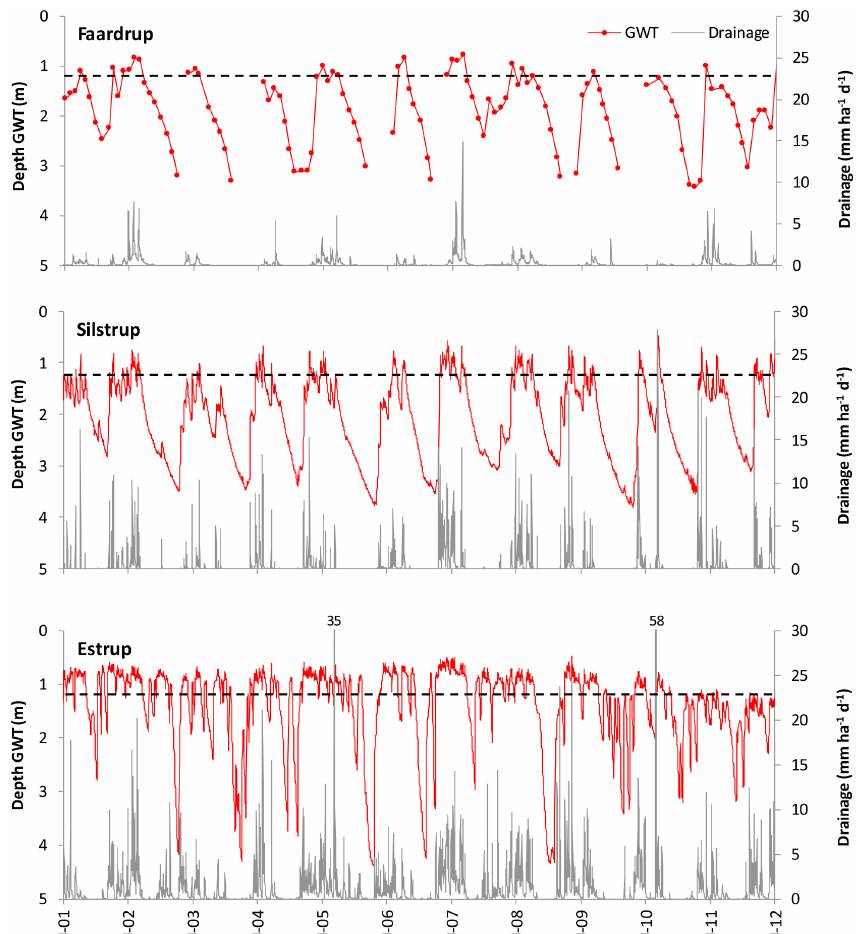
Figure 3. Drainage and depth to groundwater table (GWT) in 2001–2012 at Faardrup, Silstrup and Estrup. The black dashed lines indicate tile drain